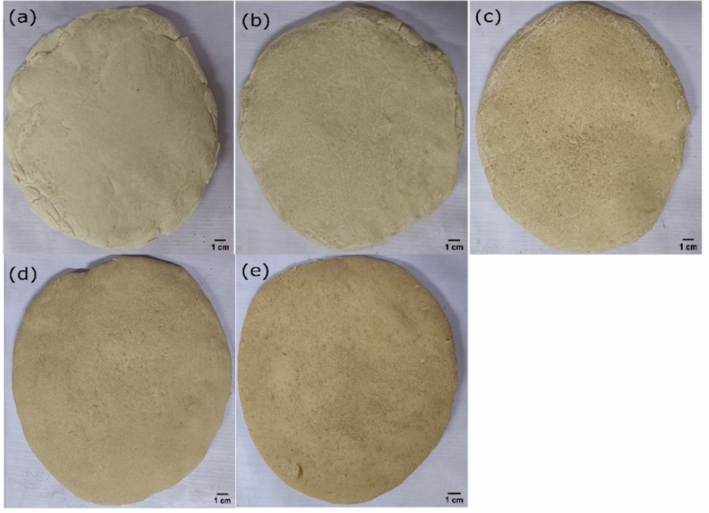
Figure 1. The top view of different samples. ( a ) WF0, ( b ) WF25, ( c ) WF50, ( d ) WF75, and ( e ) WF100 (Scale bar 1